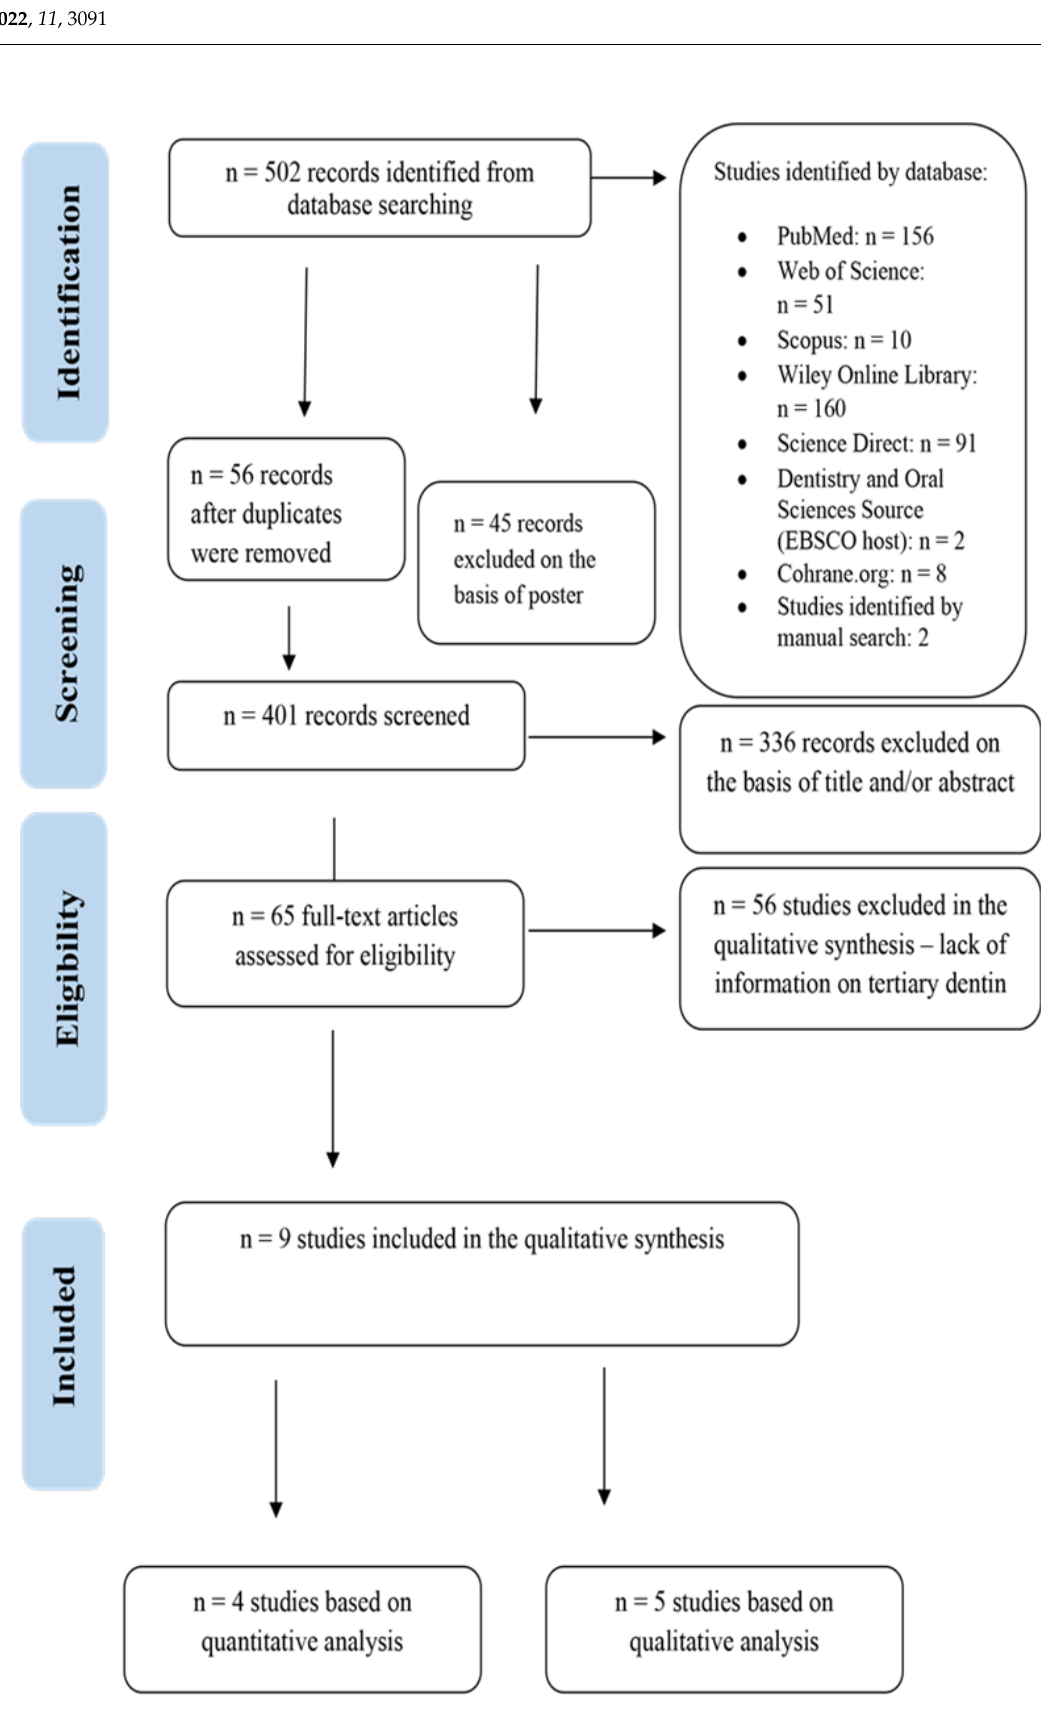
Figure 2. Preferred Reporting Items for Systematic Reviews (PRISMA) flow diagram of the search